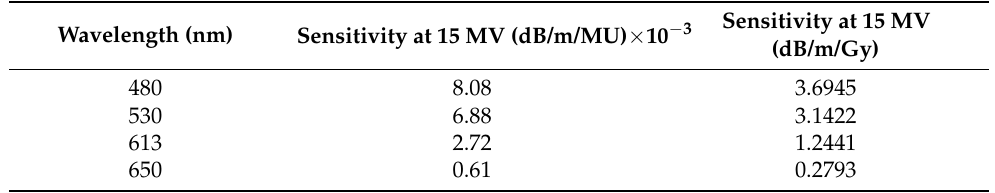
Table 2. Sensitivity of INO fibre at selected wavelengths for fibre irradiated with X-ray beam energy of 15 MV and the estimated dose at 15 MV spectra.